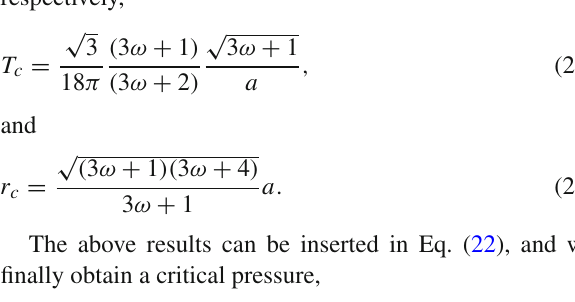
and the temperature